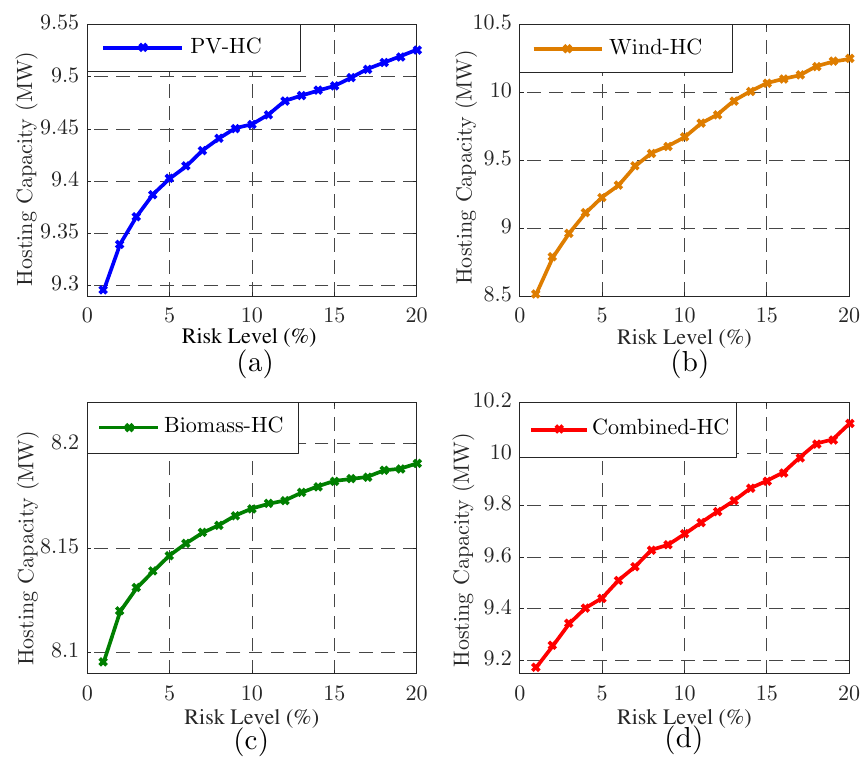
Figure 4. The HC obtained via the proposed DRO-HC method with different risk levels for different technologies including: ( a ) PV; ( b ) wind; ( c ) biomass; and ( d ) combination of PV, wind and